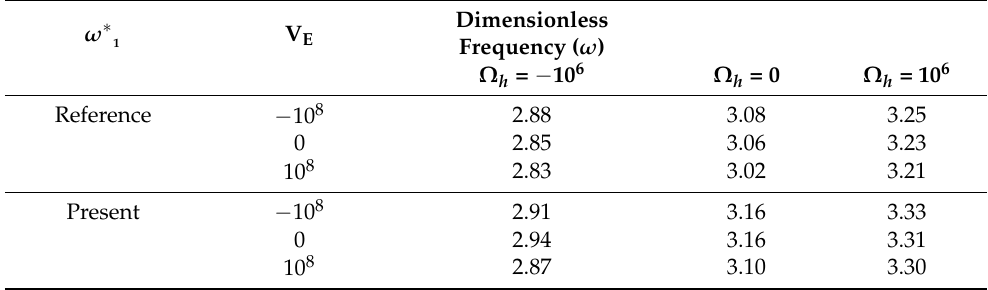
Table 5. Validation of present work with respect to Ref.